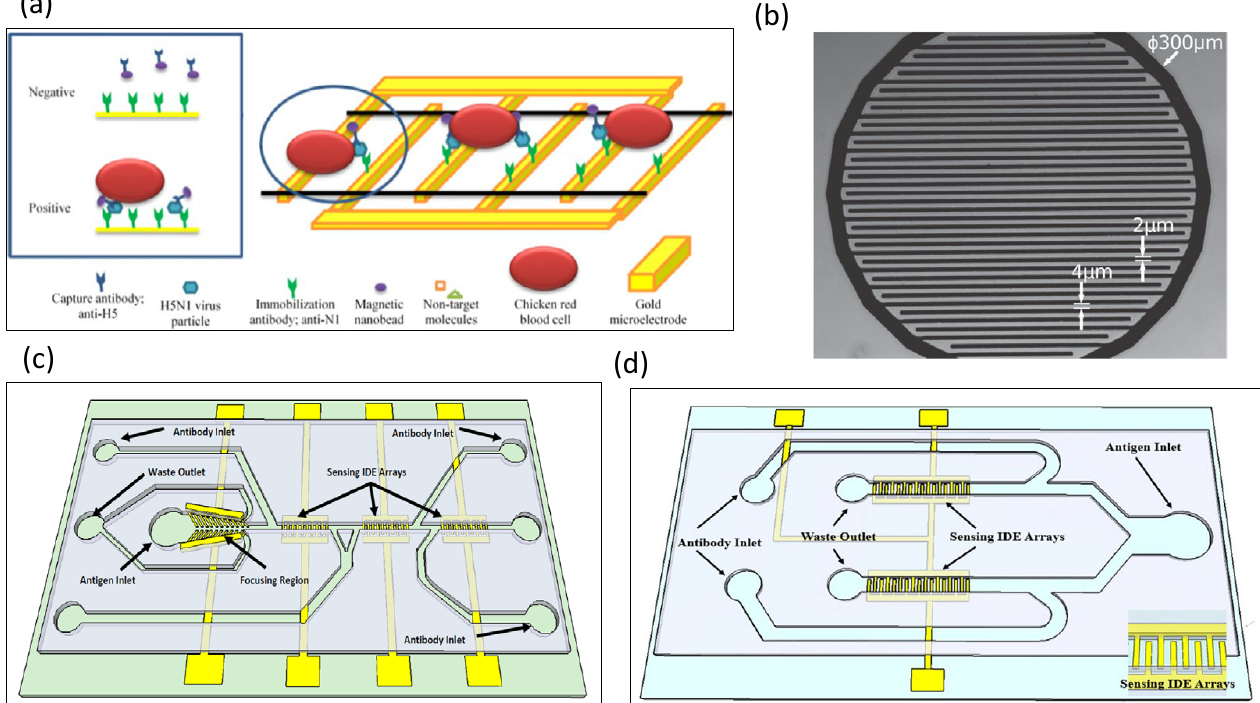
Figure 4. Glass-based impedance biosensors for detecting bacteria. ( a ) A polyclonal antibody was immobilized on the surface of a microelectrode and bound to avian influenza virus H5N1 to generate an impedance signal. Reproduced with permission from [55]. Copyright Biosensors and Bioelectronics 2012. ( b ) Pyrex wafers were used as substrates for impedance sensors. Reproduced with permission from [57]. Copyright Biosensors and Bioelectronics 2015. ( c ) An impedance-based bio- sensors were used to simultaneously detect Salmonella Serotypes B, D, and E. Reproduced with permission from [58]. Copyright Scientific Reports 2018. ( d ) There were two sensing areas in the chip, and the sensing electrodes were composed of interdigitated electrodes. Reproduced with per- mission from [60]. Copyright PLoS ONE 2019. are related to improving the sensitivity. As the combination of antigen and